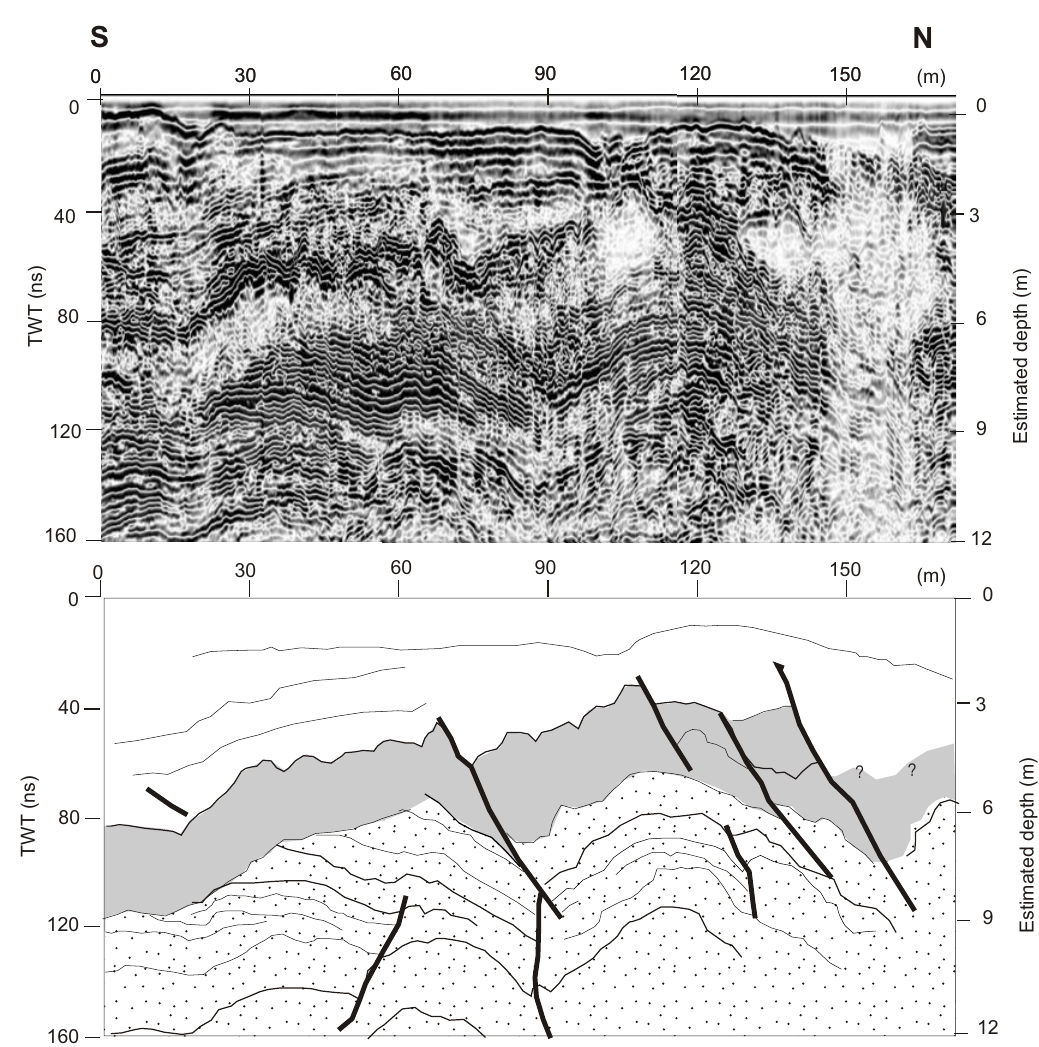
Fig. 7 – GPR (upper) and line drawing (lower) of a section from the Atalaia Beach showing Miocene deposits (dotted and toned intervals) strongly deformed by folds and steeply-dipping normal faults,